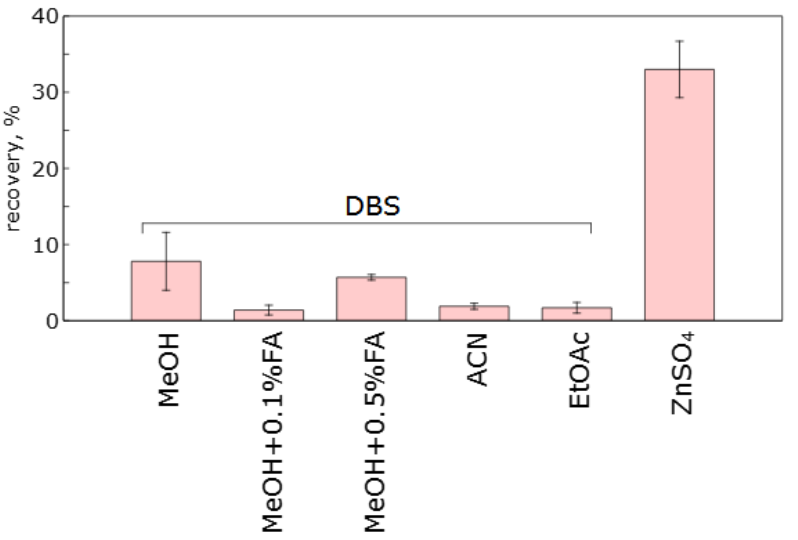
Figure 3 . Diagram of peak area of K-142 on chromatograms of spiked samples prepared using DBS with different extracting solvents as well as whole blood mixed with the ZnSO 4 -containing precipitation solution.